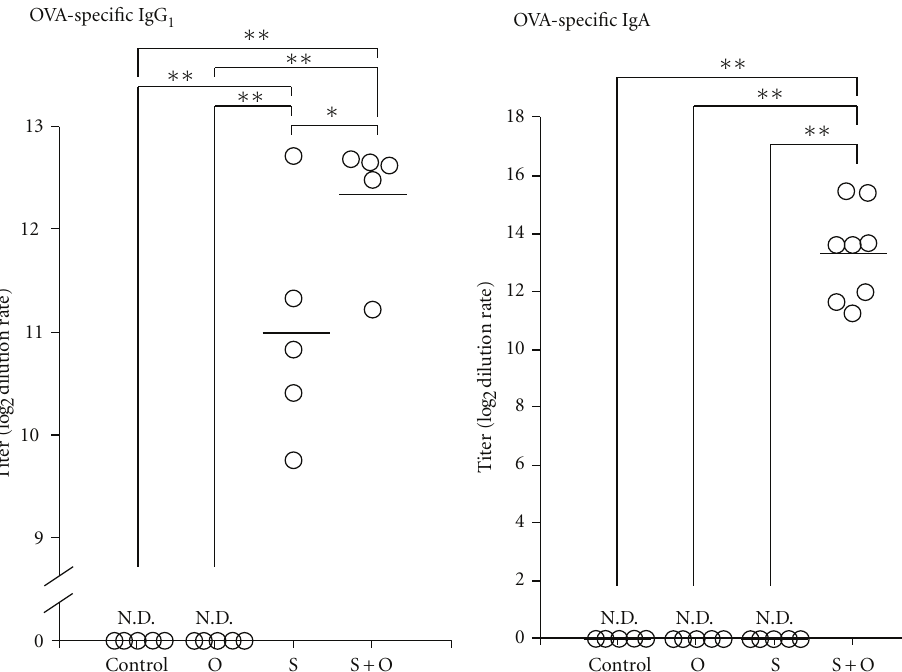
Figure 6: E ff ects of the maternal exposure to food antigens during lactation and the maternal allergic status on OVA-specific IgG1 and IgA levels in breast milk. We found OVA-specific IgG1 only in the breast milk from OVA-sensitized mothers, which implies that mother mice secrete IgG1 into their breast milk. We found OVA-specific IgA only in the breast milk from OVA-sensitized and OVA-exposed mothers. Data are shown as the means and individual data points. N.D.: not detectable. ∗ P < 0 . 05, ∗∗ P < 0 . 01, n =